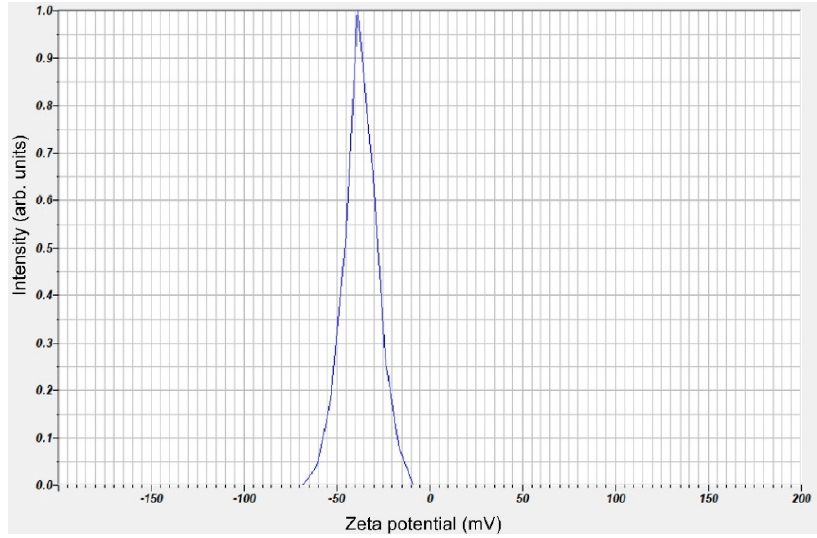
Figure 1. Zeta-potential of dextran-thyme magnesium-doped hydroxyapatite (10MgHAp-Dex-thyme) nanoparticles in suspension.